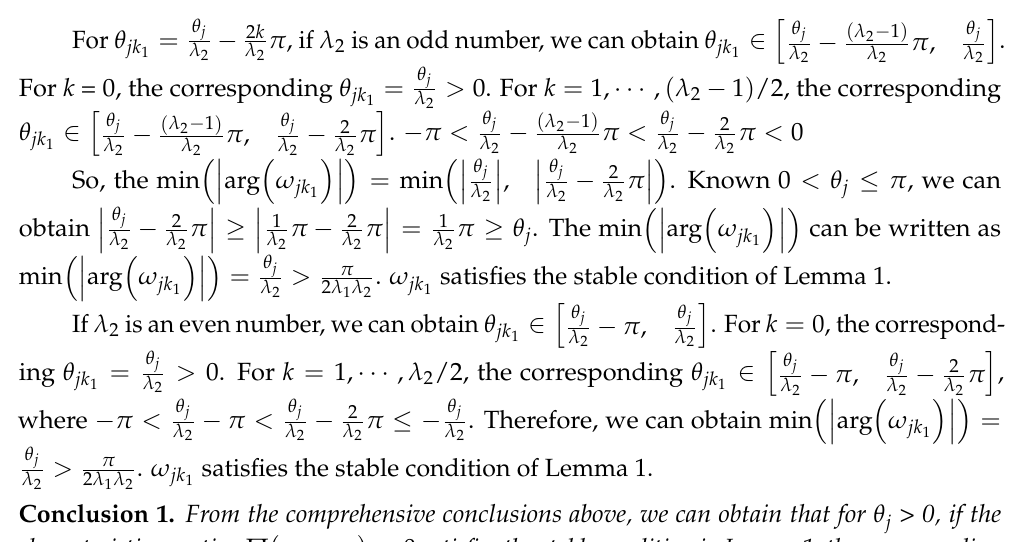
Figure 3. Diagram of Roots of Fractional-Order Characteristic Equation.